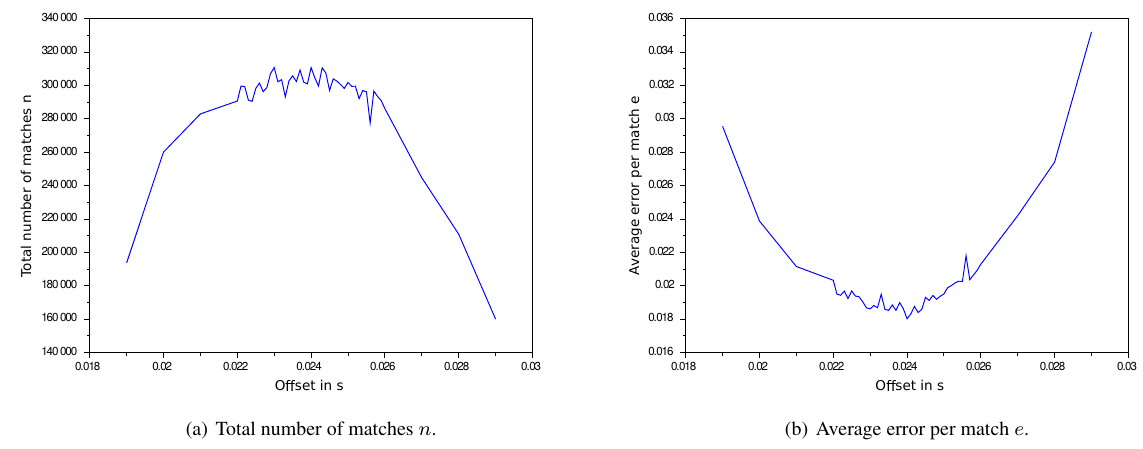
Figure 6. Results generated by the approach to calculate timestamp offsets for large datasets. Both measurement graphs belong to the parking area dataset, but they display different criteria to evaluate the clarity of the resulting point cloud.